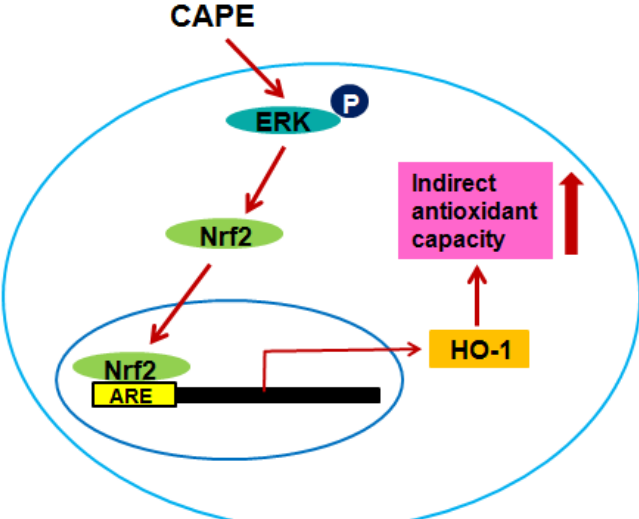
Figure 7. The ERK-Nrf2 signaling pathway of CAPE contributing to indirect cellular antioxidant